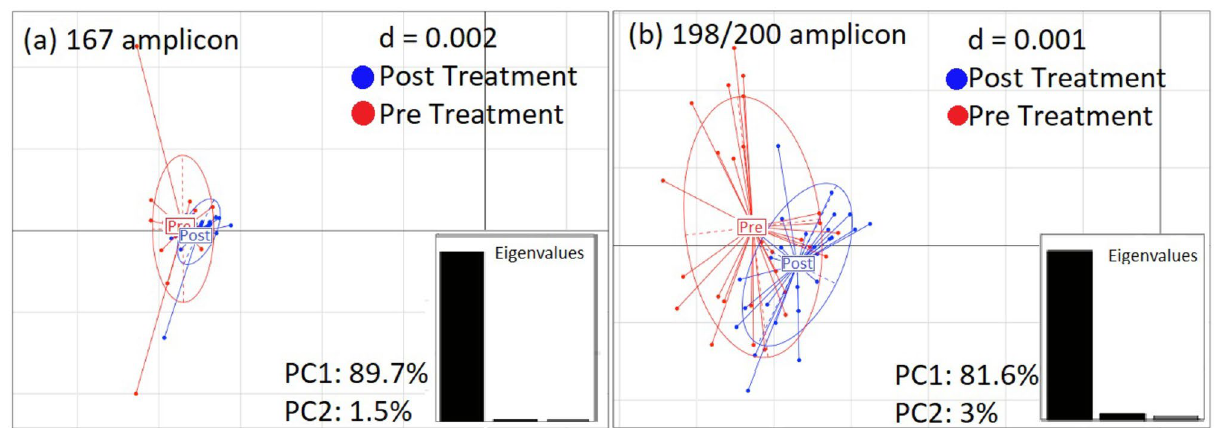
Figure 2. Principal component analysis of N. americanus isotype-1 β-tubulin DNA sequences obtained pre- and post-treatment. Eigenvalues are shown in lower right-hand corner. The first bar represents PC1, second bar represents PC2, and third bar represents PC3. Most of the values (89.7% and 81.6% for 167aa and 198/200aa, respectively) are aligned in PC1, confirming that most of the data points lie on the same axis plane, representing minimal genomic variation. Alternatively, if there were a treatment related enrichment of a particular genotype, the pre- (red) and post- (blue) treatment would not overlap, and Eigenvalues would be more evenly distributed between PC1, PC2, PC3, etc. The letter “d” represents appropriate effect size for comparison between pre- and post-treatment mean values. d = ((mean alternate allele frequency of post-treatment group)-(mean alternate allele frequency of pre-treatment group))/Standard